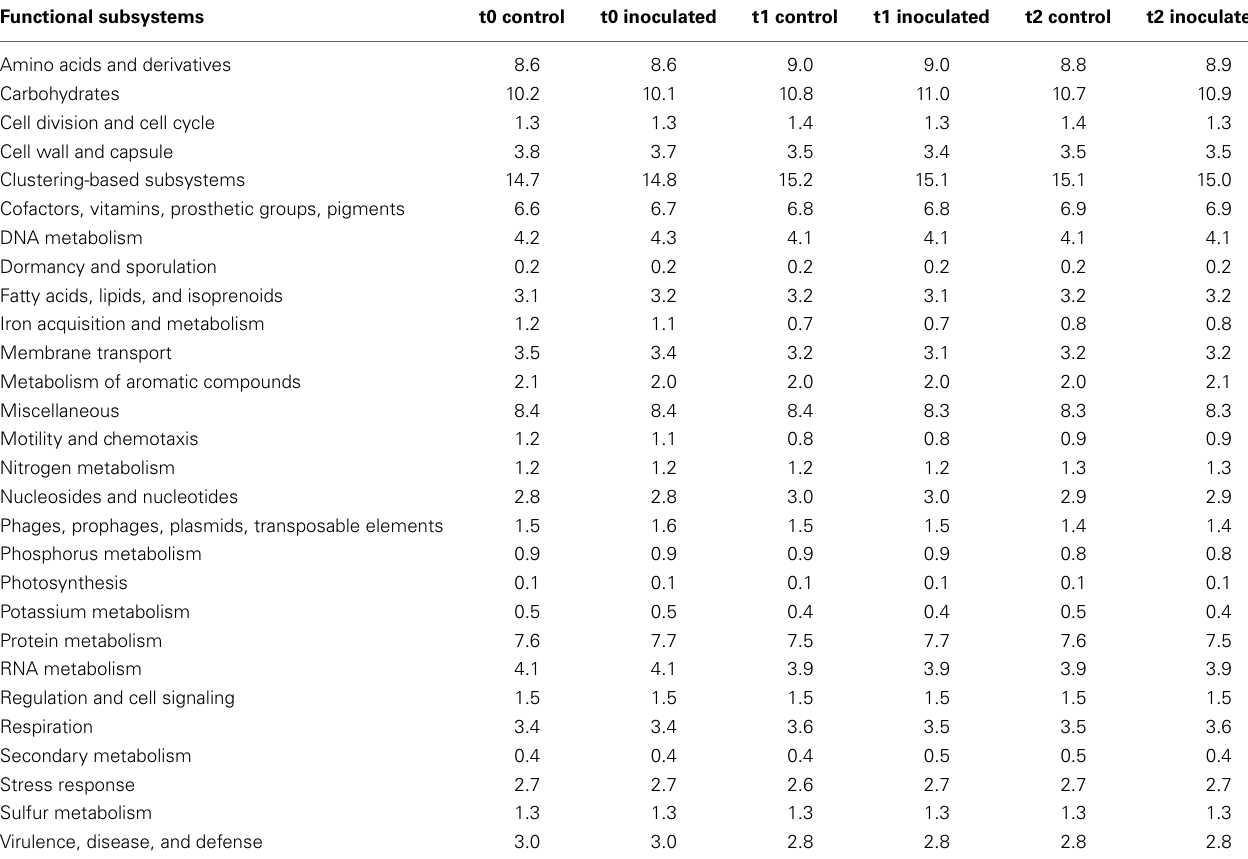
Table 7 | Relative distributions of functional subsystems calculated within the MG RAST analysis software with default